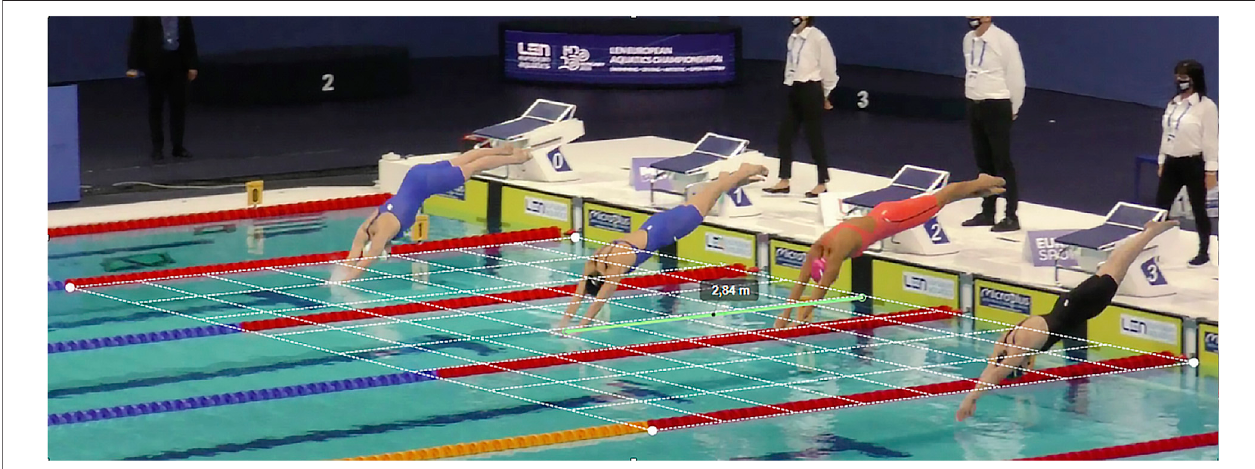
FIGURE1| Basicgraphicaldescriptionoftheprocedureformeasuringtheswimmer ’ sentrydistanceintothewaterafterthestart.Similarprocedureswereusedto measure emersion distance.